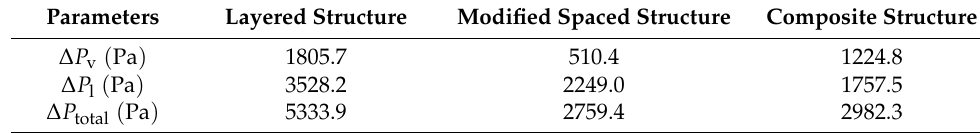
Figure 6. Comparison of the maximum heat transfer capability of the HPBPs with different internal structures. Table 4. Pressure drops in HPBPs with different internal structures at a cell voltage of 0.45